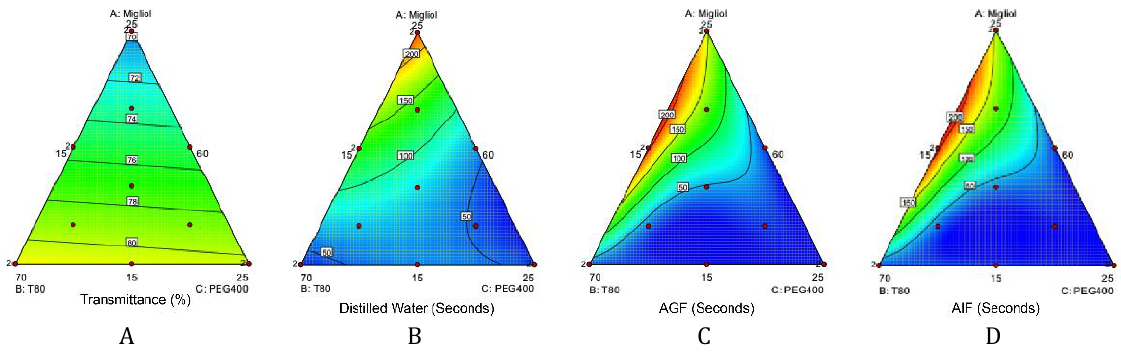
Figure 1A. Contour plot of transmittance (%) of SNEDDS in distilled water, B. Emulsifying times of SNEDDS in media of distilled water, C. artificial gastric fluid (AGF), and D. artificial intestine fluid